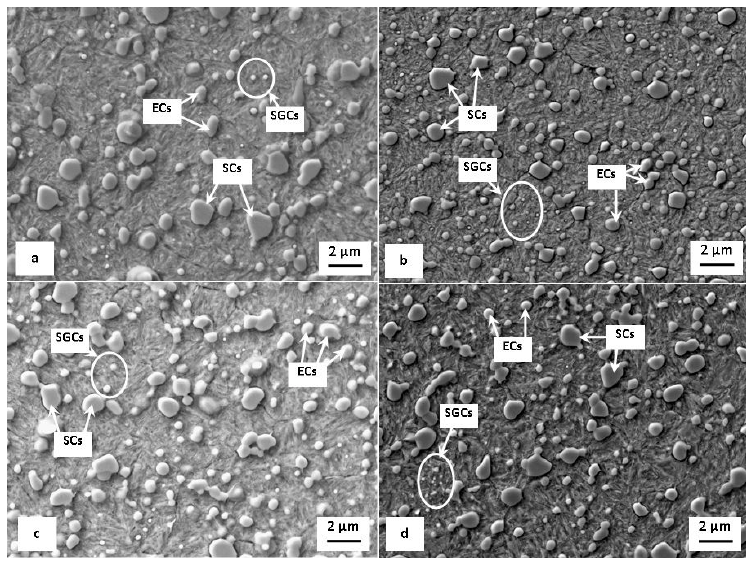
Figure 4. SEM micrographs showing the microstructure of the specimens after tempering at 530 °C: ( a ) CHT, ( b ) SZT at − 140 °C, ( c ) SZT at − 196 °C, and ( d ) SZT at − 269 °C. γ R —retained austenite; ECs—eutectic carbides; SCs—secondary carbides; SGCs—small globular carbides. The decrease in the